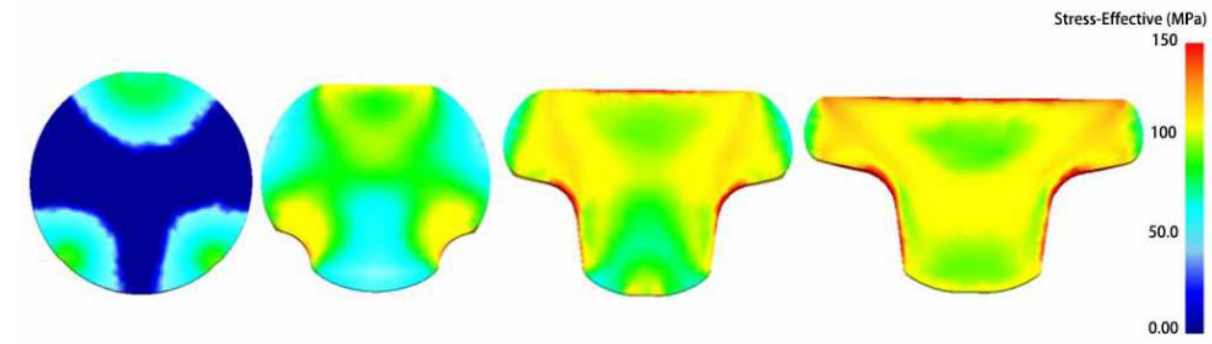
Figure 15. Deformation process of T-shaped blank.